Question: What kind of plot is shown here?
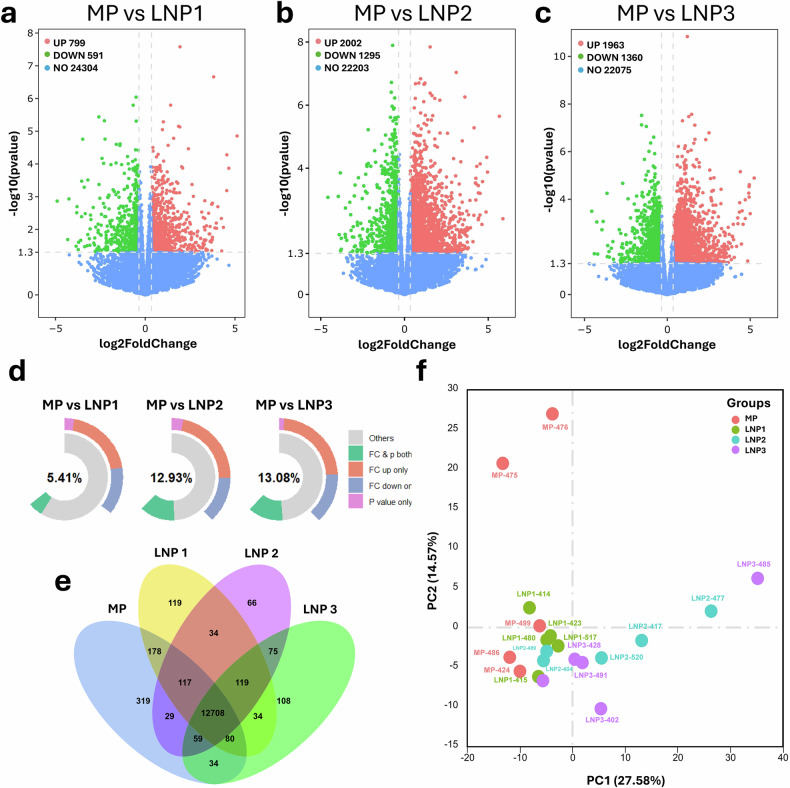
Answer: scatter